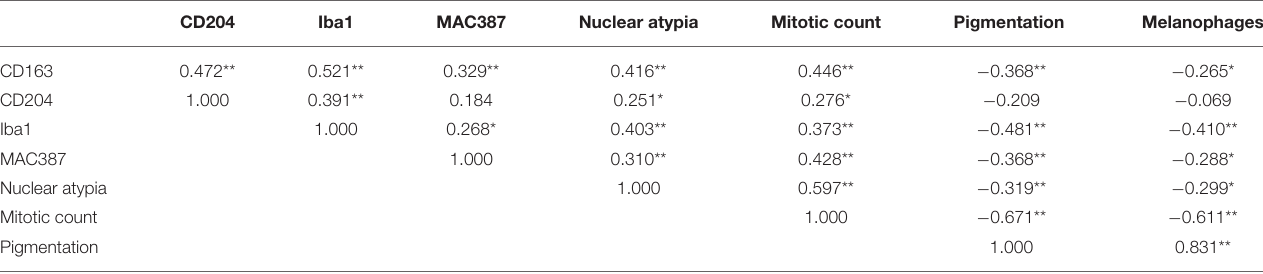
TABLE 2 | Correlation analysis (Spearman rank correlation coefficient, ρ ).